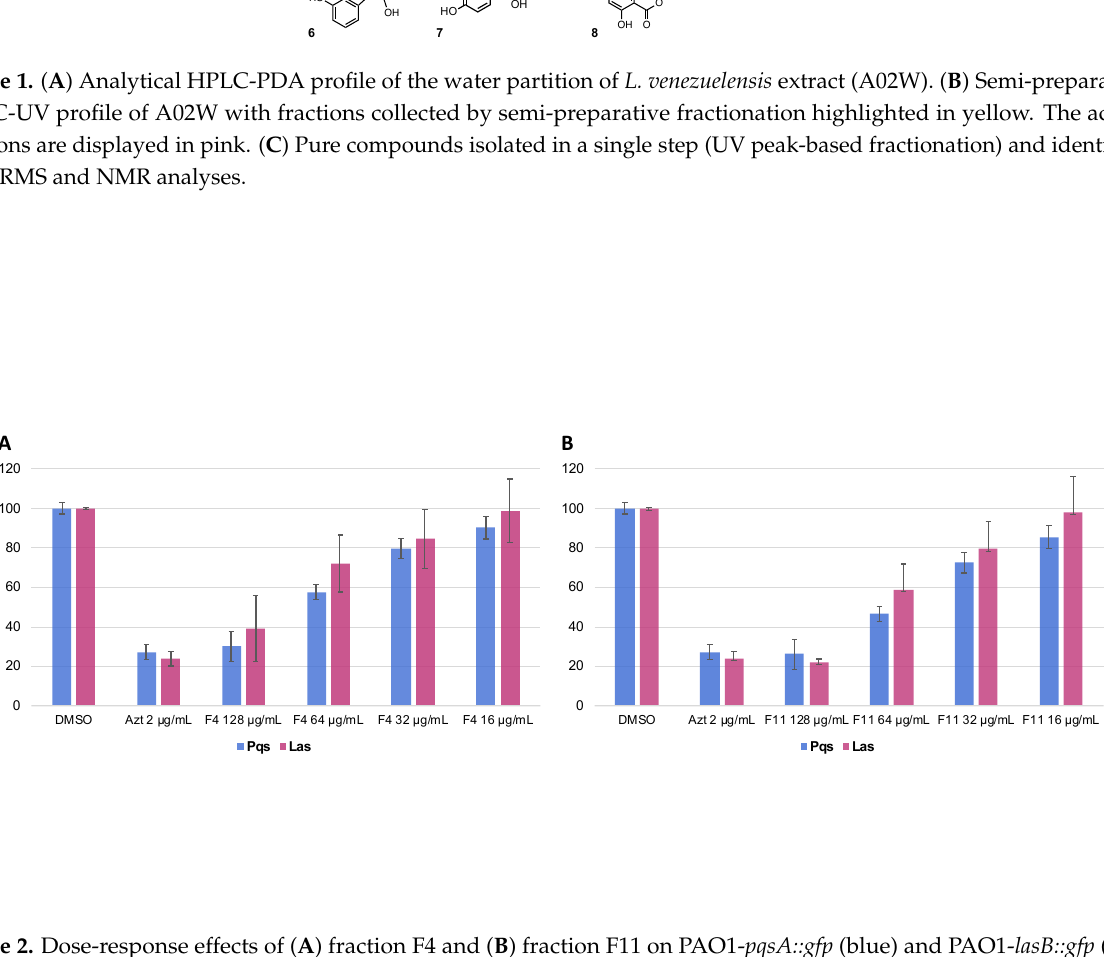
Figure 2. Dose-response effects of ( A ) fraction F4 and ( B ) fraction F11 on PAO1- pqsA::gfp (blue) and PAO1- lasB::gfp (red) reporter strains. All experiments were performed in a triplicate manner (technical and biological replicates), only represen- tative data are shown. Azithromycin was used as a positive control. Fluorescence was normalized to 100% of the reporter strains grown with 1.28% DMSO (negative